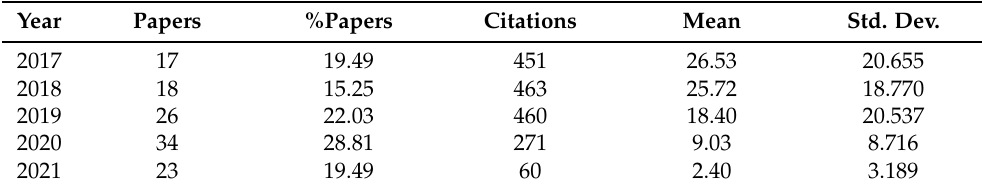
Table 3. Number of papers, percentage of papers over the total, number of citations, mean of citations and standard